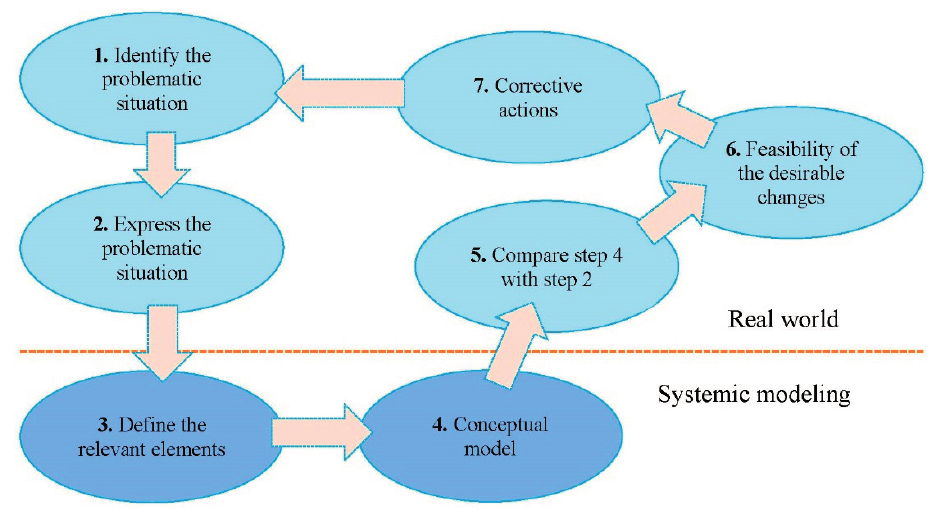
Figure 9. The steps involved in the soft systems methodology. Adapted from